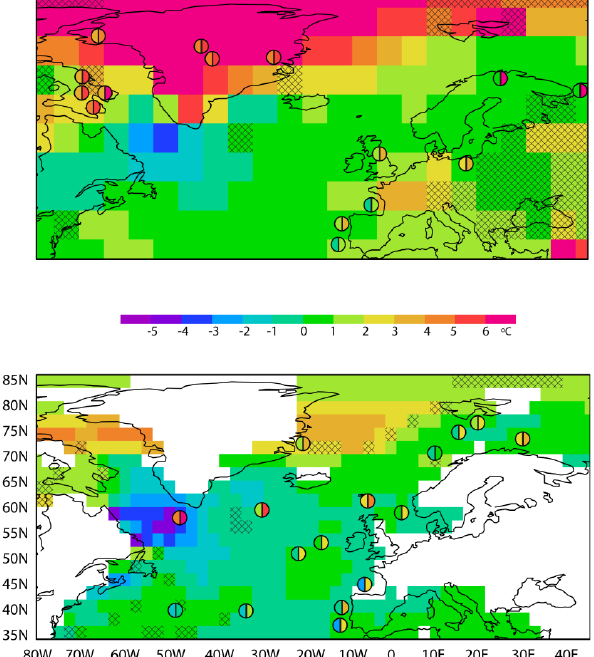
Fig. 7. Model–data comparison for atmospheric July surface tem- perature anomalies (upper panel) and August sea surface tempera- ture anomalies (lower panel; ◦ C). Shown are results from regime 2 including the impact of changes in elevation and extent of the GIS compared to the PI-ctrl. Non-hatched areas indicate the re- gions for which the simulated anomalies are significantly differ- ent at the 5% significance level compared to internal climate vari- ability in the LIG-ctrl simulation (calculated with a t-test). Cir- cles indicate maximum LIG proxy-based temperatures from the CAPE-dataset (CAPE-members, 2006) complemented with data of Hillaire-Marcel et al. (2001) and S´anchez Go˜ni et al. (2005, 2008, 2012). The left-hand side of the circles depicts the minimum and the right-hand side the maximum estimate of the reconstructed tem- peratures. Because of the coarse resolution of the model we have decided to incorporate several data points even though they fall at least partly outside of the significantly impacted